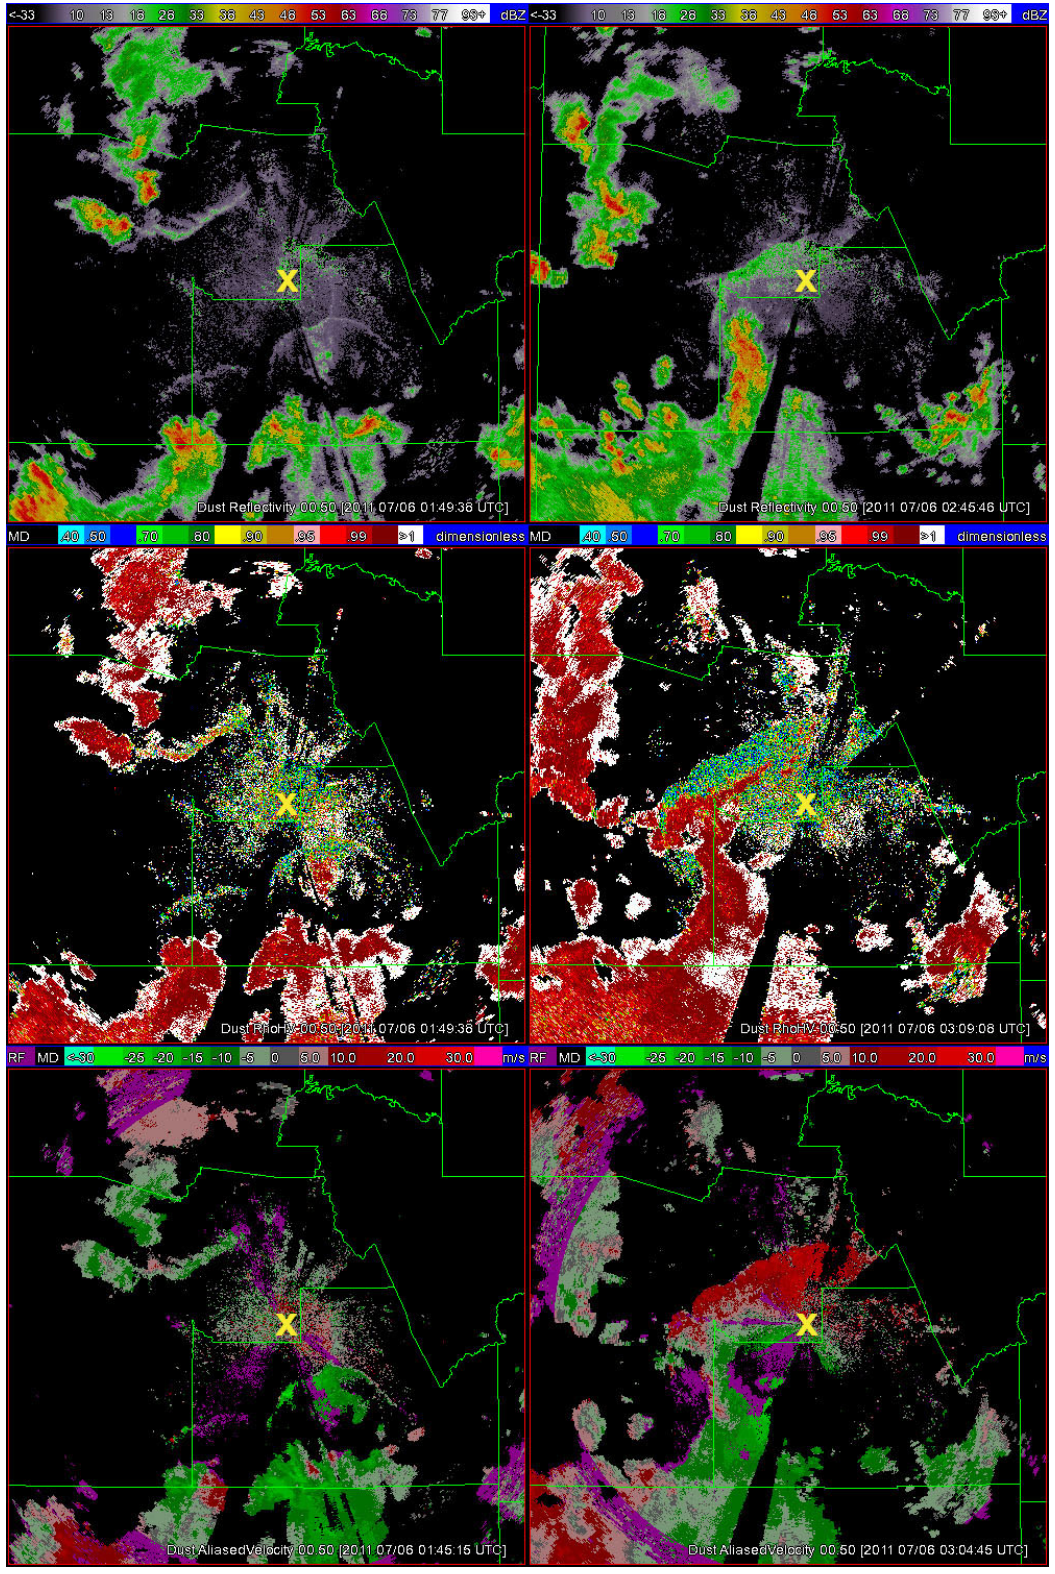
Fig. 3. Radar Z hh at 01:50 (upper left) and 02:46 (upper right) UTC, ρ hv at 01:50 (middle left) and 03:09 (middle right), and velocity at 01:45 (lower left) and 03:05 (lower right) UTC; radar location is marked with “x”.